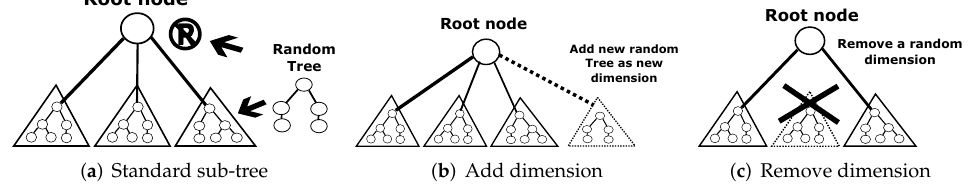
Figure 6. The three possible mutation types in M3GP standard sub-tree, add dimensions and remove dimensions.